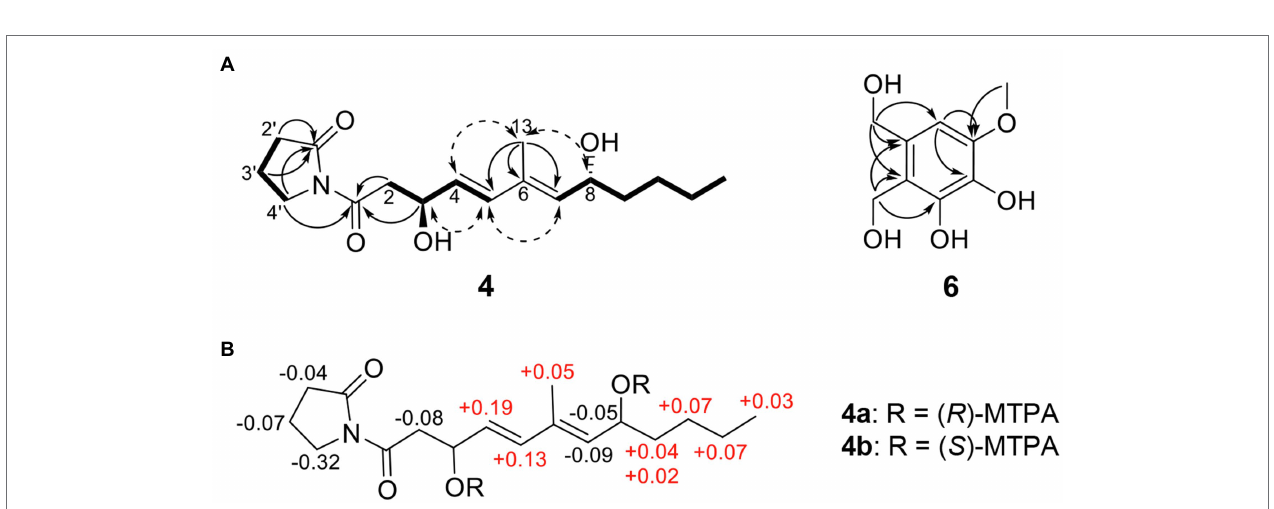
FIGURE 3 | Structural identification of new compounds. (A) Key HMBC (arrow), COSY (bold line), and NOESY (dotted arrow) correlations of compounds 4 and 6 . (B) The Δ δ S – δ R values for ( R )- and ( S )-MTPA esters of compound 4